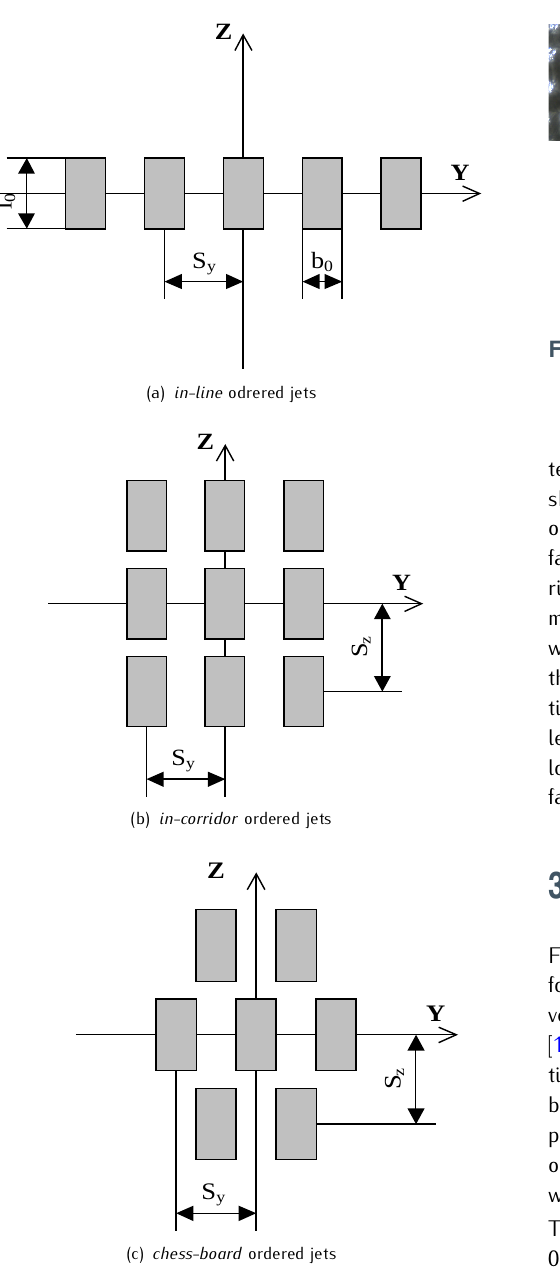
Figure 1. Types of jet systems with rectangular geometry [12].